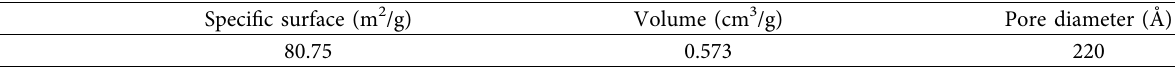
Figure 3: Isotherm of adsorption/desorption of N Table 1: Textural characteristics of